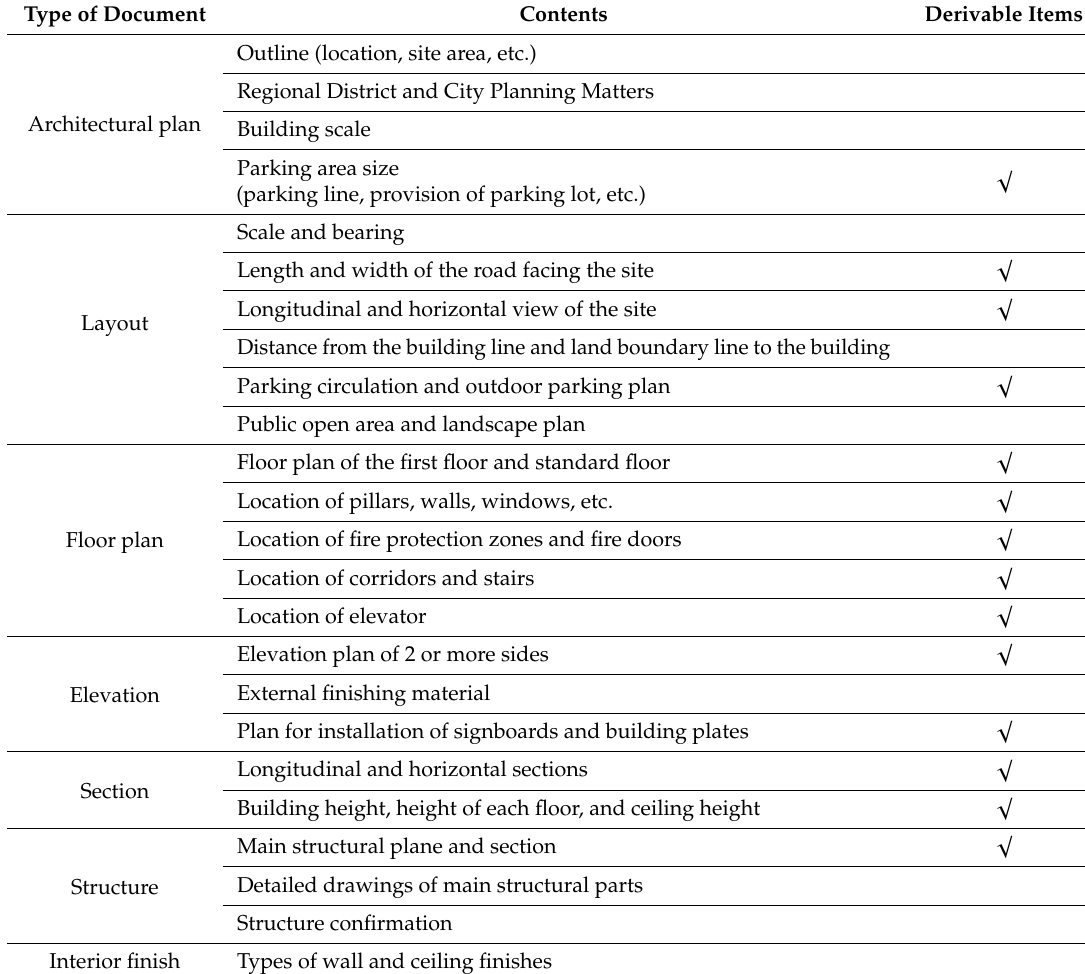
Table 2. Design documentation items required at the licensing stage in